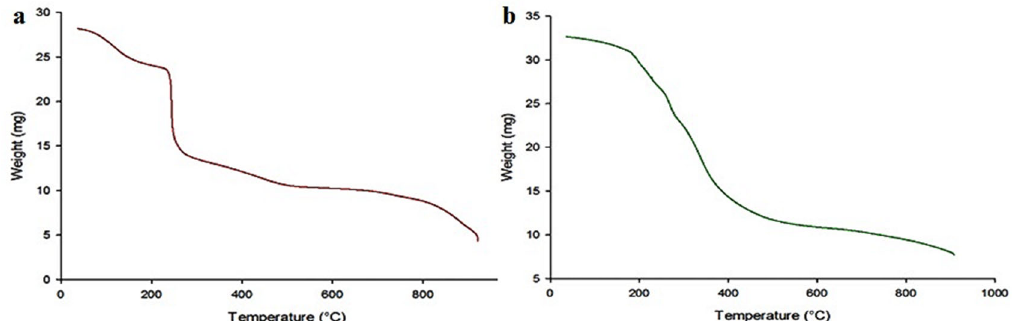
Figure 11. Thermogravimetric (TGA) analysis of, ( a ) sodium alginate ‐ gelatine printing ink and ( b ) 3D printed sodium alginate ‐ gelatine nanoparticle formulation.